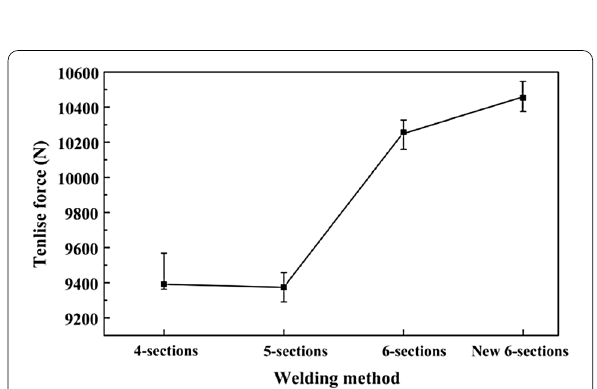
Figure 22 The maximum tensile force of welded joints under different welding